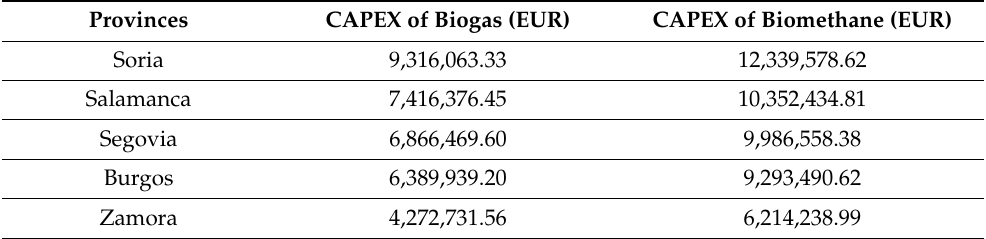
Table 11. Biogas and biomethane production